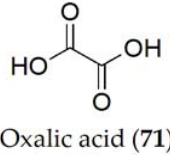
Figure 14. Phytotoxin isolated from Sclerotinia sclerotiorum .